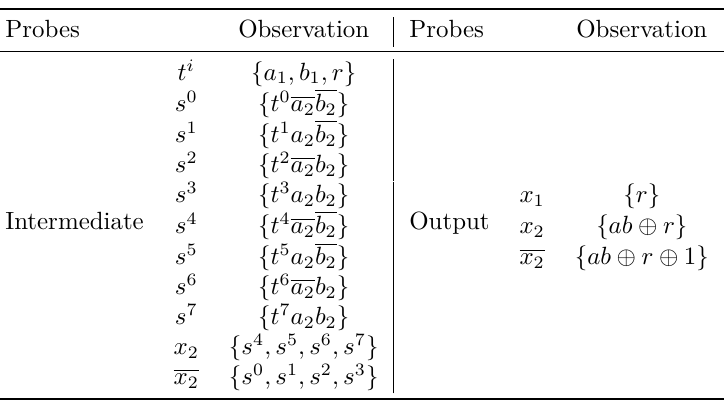
Table 1: Observation from glitch-extended